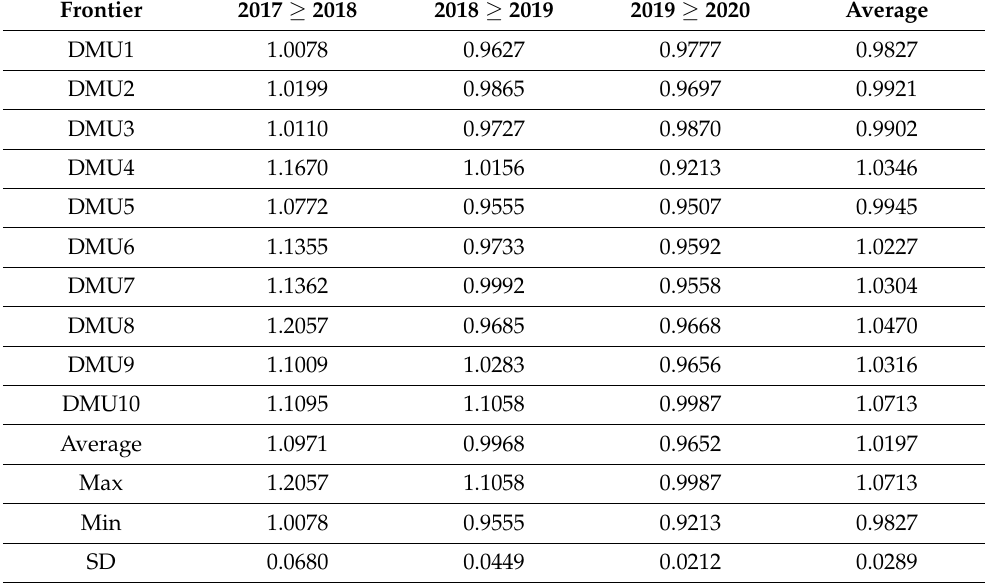
Table 8. Technological change of DMUs